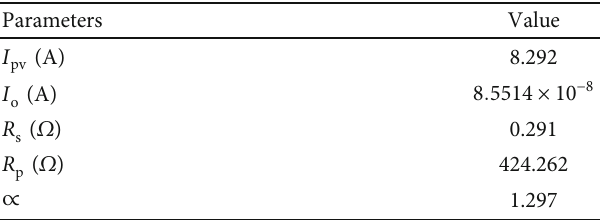
Table 2: Performance evaluation of single-diode PV MLP model. Parameters